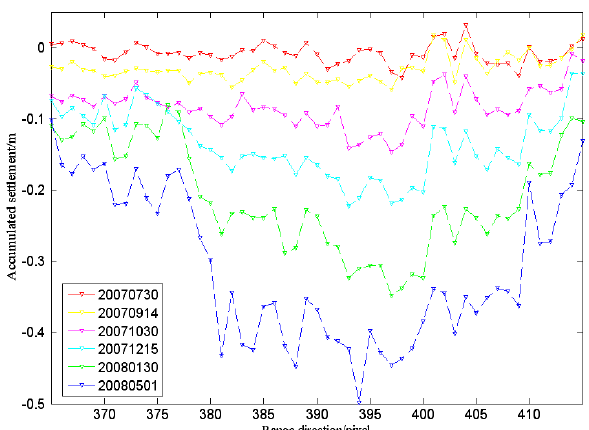
Figure 3.Time series settlement map of study region